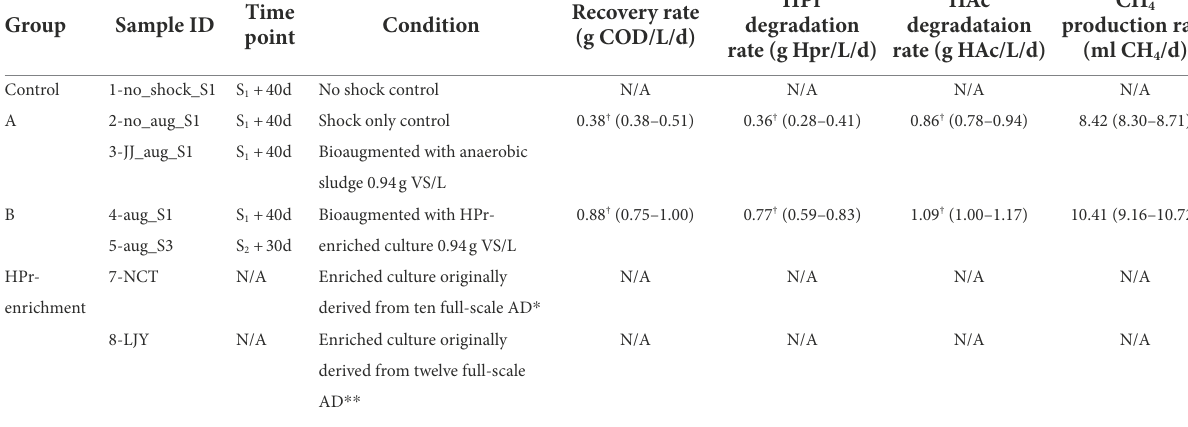
TABLE 2 Sample information and recovery